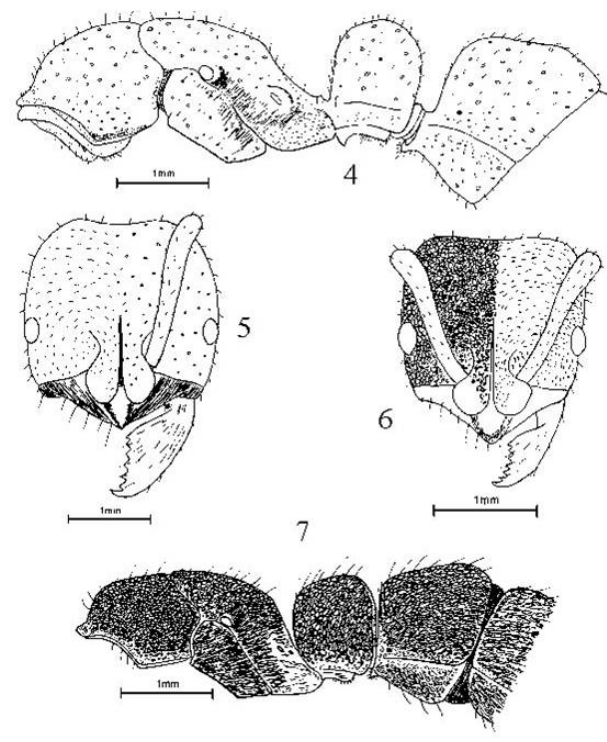
Fig 4 . The lateral view of a paratype worker of Bothroponera aspera (Iziko). Fig 5 . The head of the paratype worker of B. aspera (Iziko). Fig 6 . The head of the worker of B. berthoudi from South Africa, Eastern Cape Province, Algoa-Bay (MfN). Fig 7 . The lateral view of a worker of B. berthoudi from South Africa, Eastern Cape Province (MfN).